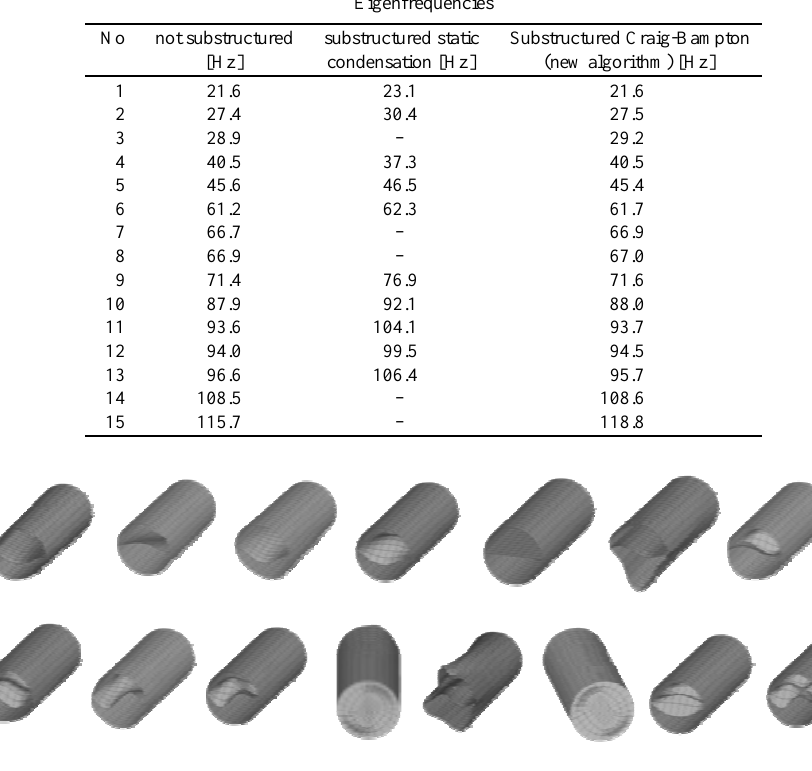
Fig. 2. Eigenmodes.